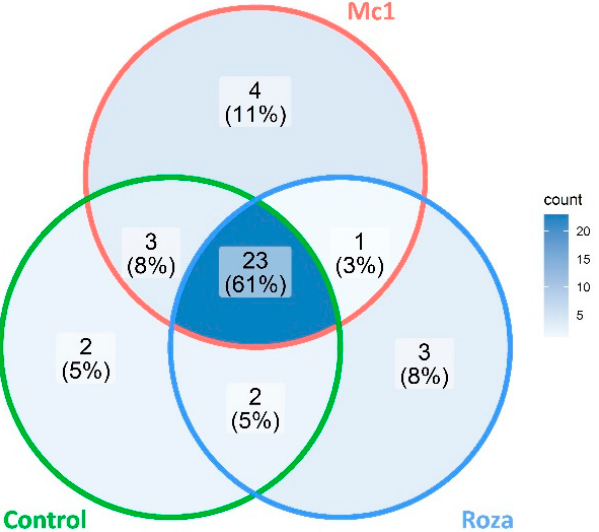
Figure 2. Venn diagram showing common and unique peaks represented by different retention times extracted from GC-FID data of SB22 plants infected with M. chitwoodi Race 1 (Mc1) and its pathotype Roza by combining all time points (2, 5, 10, and 25 DAI).